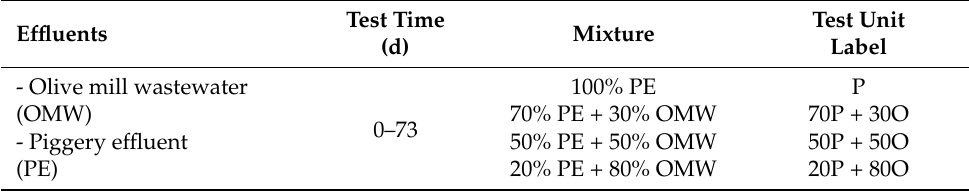
Table 1. Anaerobic digestion in batch conditions.